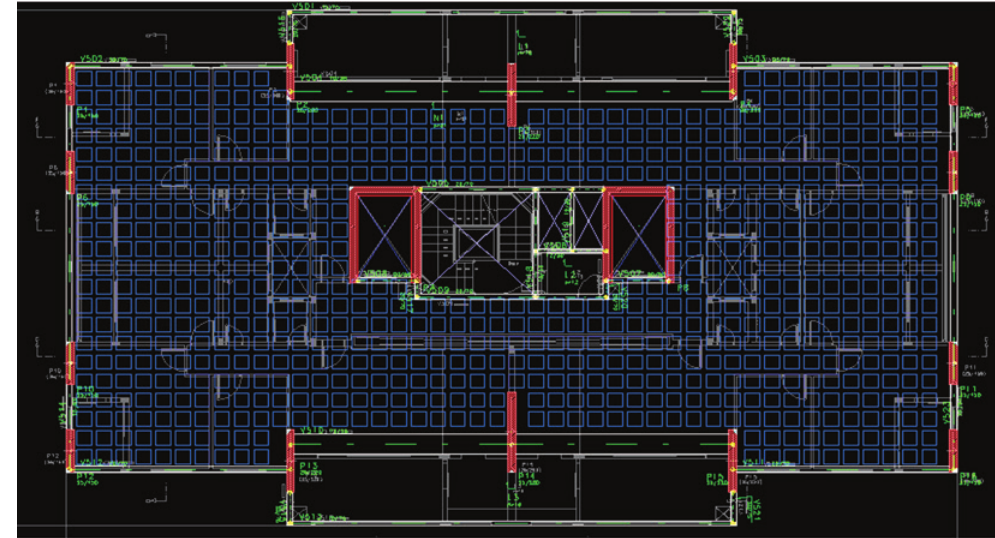
Standard floor with positioning of columns, rigid core, edge beams and ribbed and solid